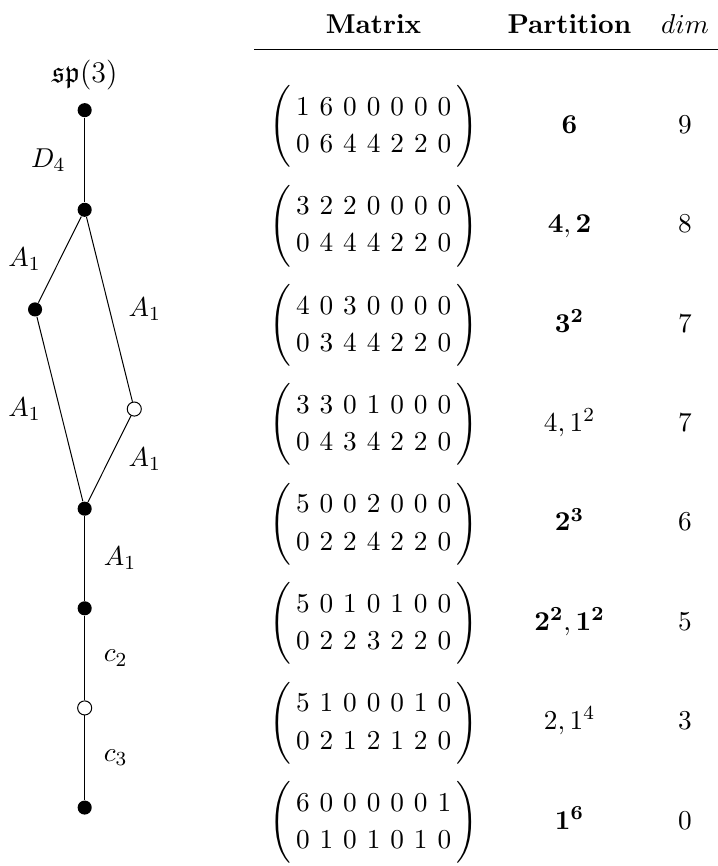
Table 21. Results obtained applying the matrix formalism to sp